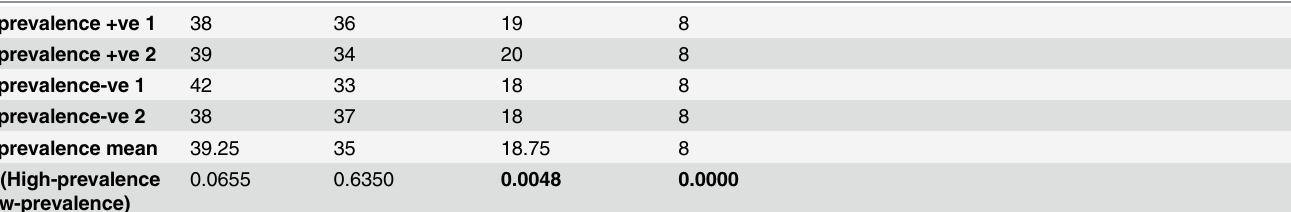
Table 2. Prevalence of Burkholderia pseudomallei recovered from directly beneath various plant species from the high prevalence site only. Species Family Samples ( n ) 95% CI Aristida sp.